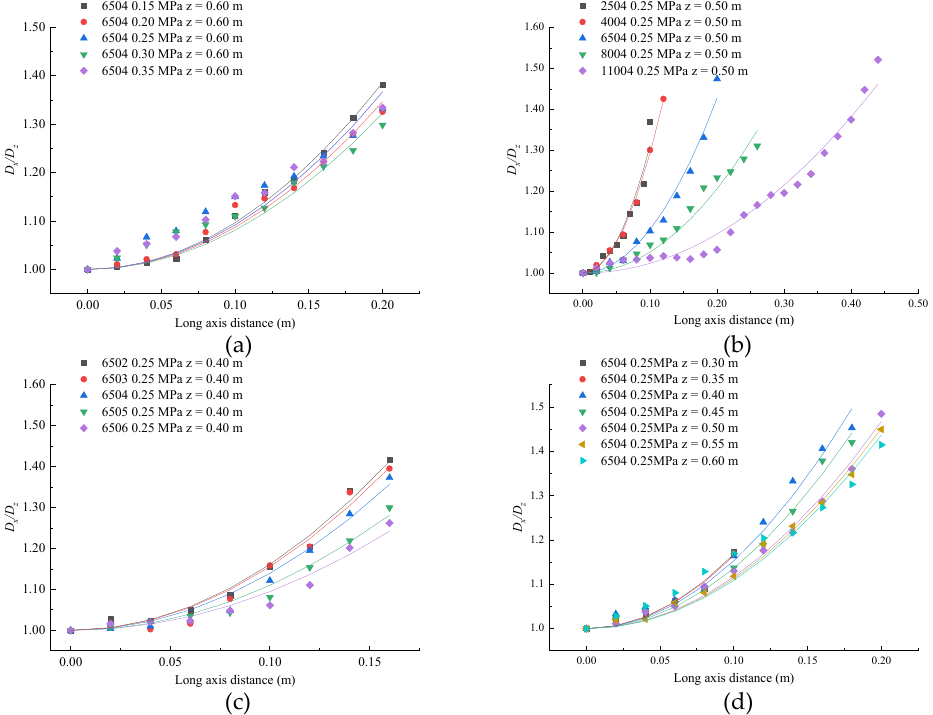
Figure 9. Fitting curves of D x / D z along the X-axis with different parameters: ( a ) spray pressure; ( b ) spray angle; ( c ) equiva- lent orifice diameter; ( d ) spray distance.